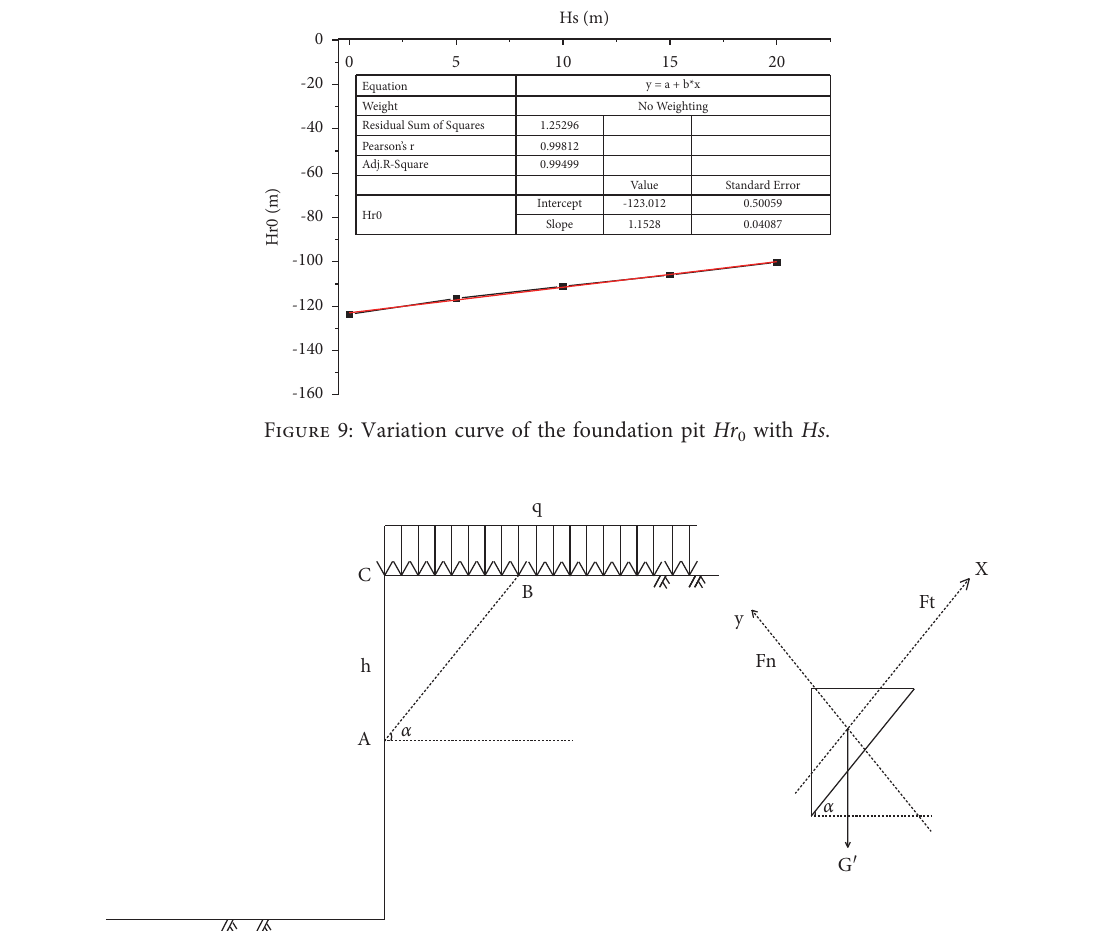
Figure 10: Stability analysis model of vertical rock sidewall